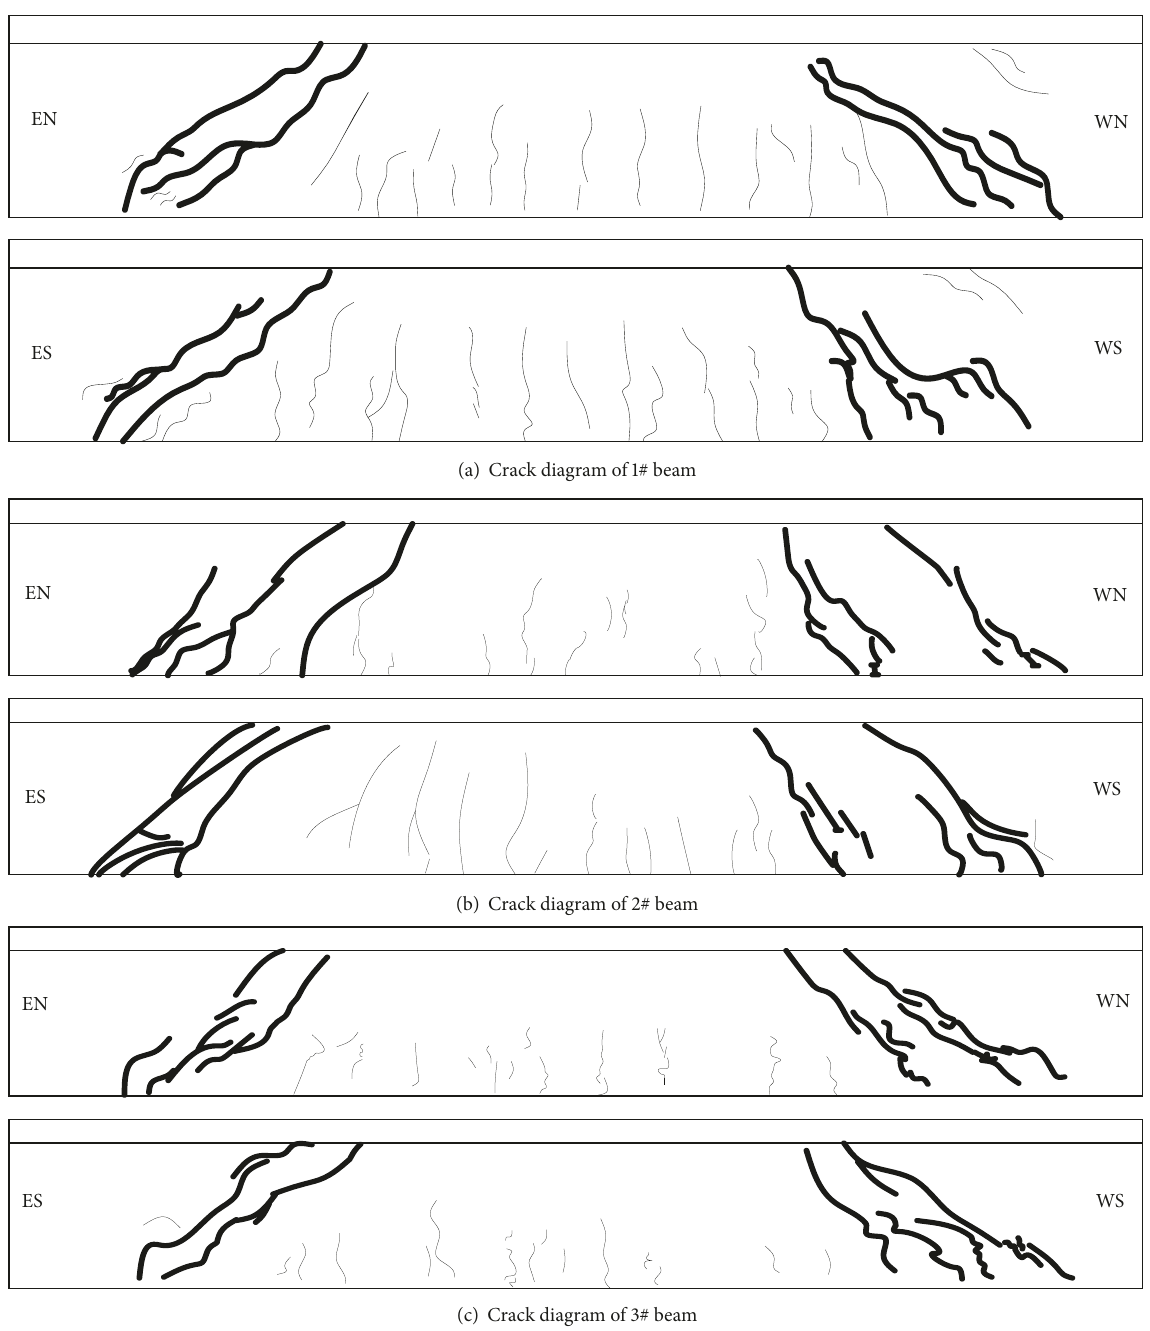
Figure 3: Crack diagram of each beam.